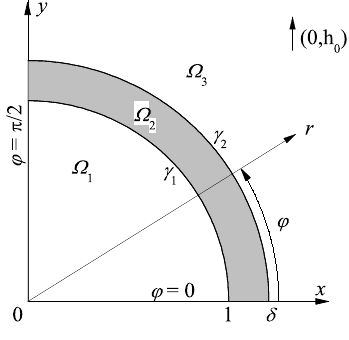
Figure 2. Computational domain for the problem under